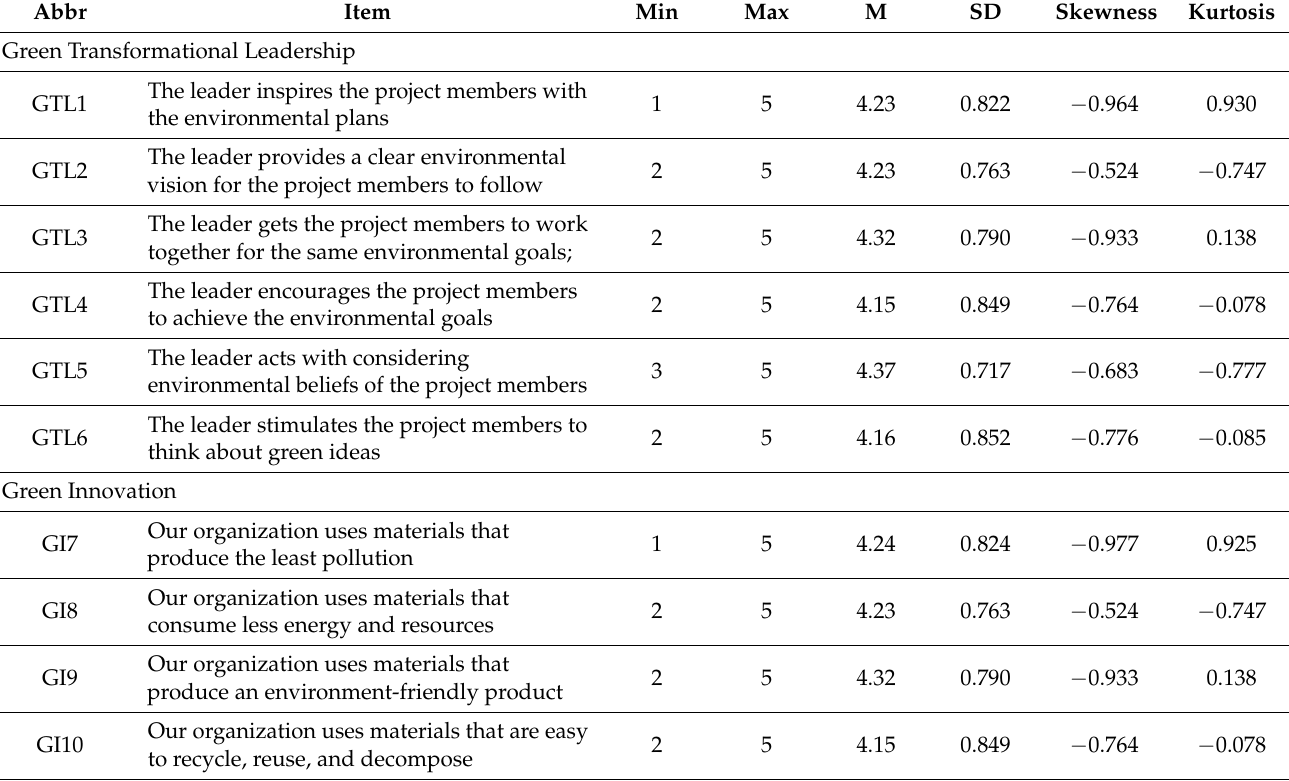
Table 1. Descriptive statistics (developed by the authors using SPSS and AMOS software based on the previous